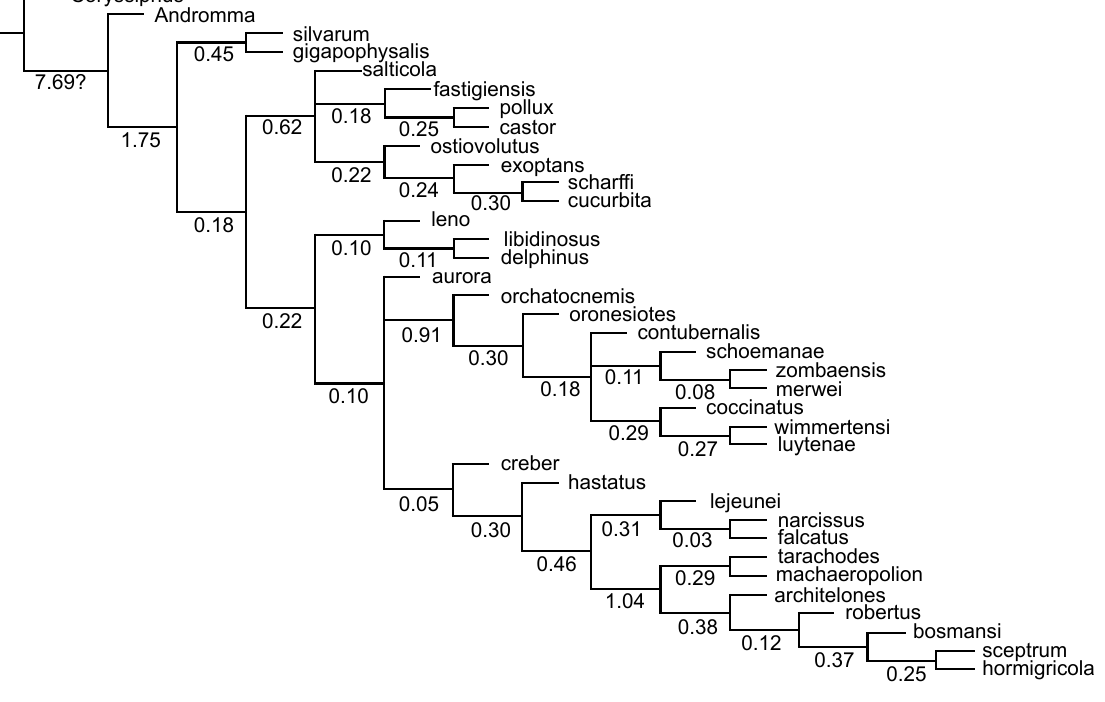
Fig. 5. cladogram obtained from the character matrix in Bosselaers & Jocqué (2000) with inclusion of H. gigapophysalis . Strict consensus of 18 trees of fit -53.061 (PAUP values), obtained under implied weighting. Bremer support values are shown under the